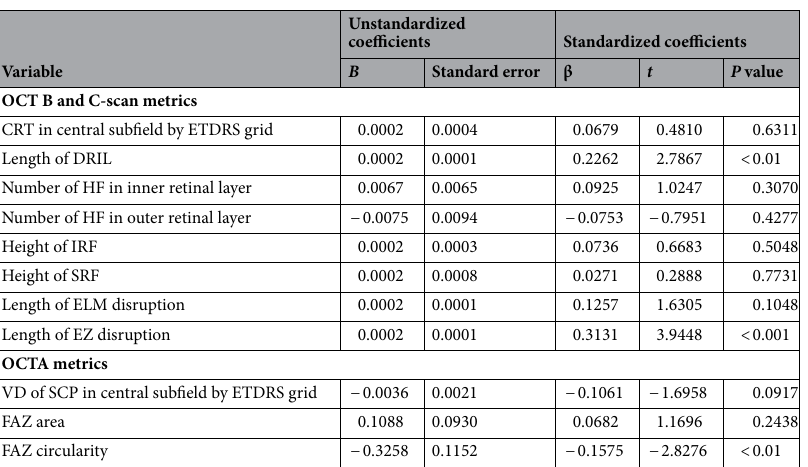
Table 3. Multiple regression analysis of the correlation between OCT-based factors and visual acuity. OCT, optical coherence tomography; DM, diabetes mellitus, CRT, central retinal thickness; ETDRS, Early Treatment of Diabetic Retinopathy Study; DRIL, disorganization of retinal inner layer; HF, hyperreflective foci; IRF, intraretinal fluid; SRF, subretinal fluid; ELM, external limiting membrane; EZ, ellipsoid zone; OCTA, OCT angiography; VD, vessel density; SCP, superficial capillary plexus; FAZ, foveal avascular